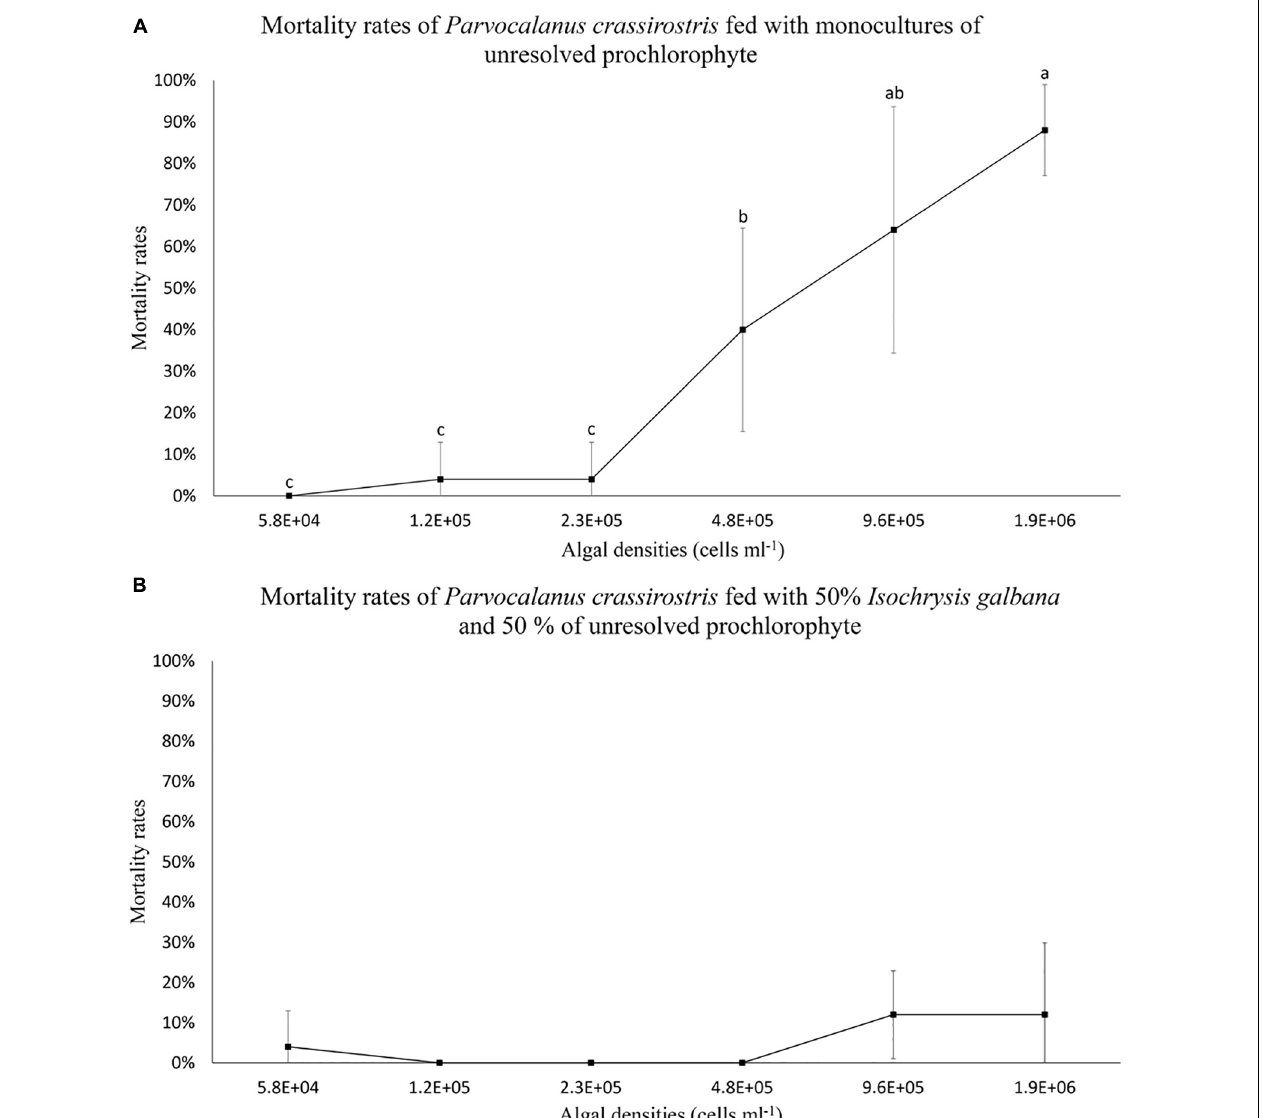
FIGURE 1 | Mean mortality rates ( ± standard deviation, SD) for Parvocalanus crassirostris exposed to different densities of an unresolved prochlorophyte presented (A) as a monoculture and (B) as a mixture of 50% Isochrysis galbana and 50% the prochlorophyte. Different letters identify significantly different means based on analysis of variance and Tukey’s post hoc pairwise comparisons ( α = 0.05). Mean mortality rates in the mixed culture (B) were statistically equivalent and not significantly different from